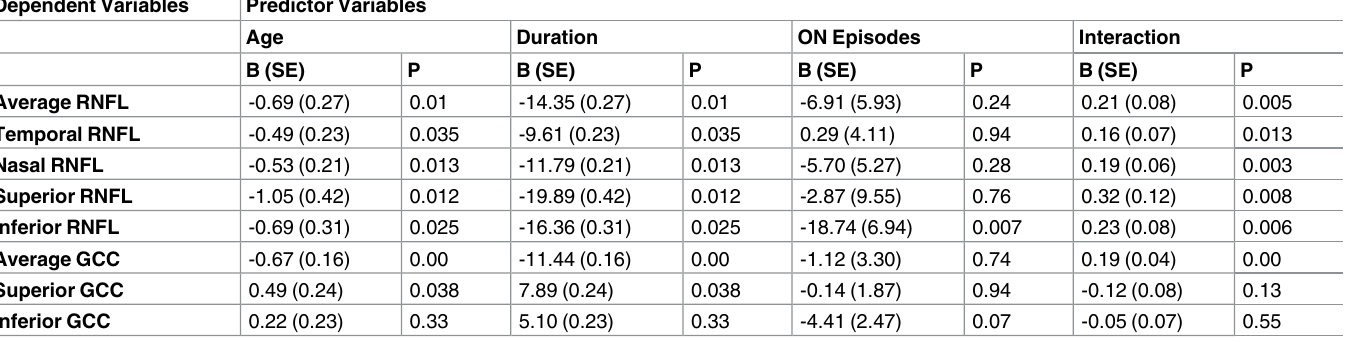
Table 5. Generalized Estimating Equation Regression Analysesfor Optical Coherence Tomography Parameters in Aquaporin-4 Antibody-Nega- tive Eye. Dependent Variables